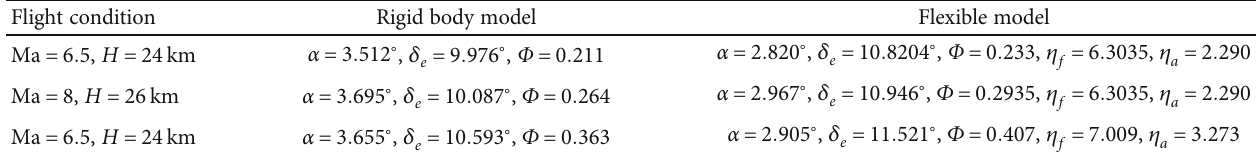
Table 1: Trim points of AHV.